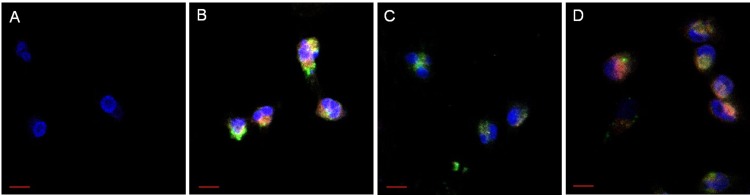
Confocal microscopy images of human breast cancer cells (MDA-MB-231) indicating uptake of fluorescent AS1411-conjugated nanoemulsions.(A) No treatment, (B) 4 hr incubation with AS1411 nanoemulsions, (C) 24 hr incubation with untargeted nanoemulsions, and (D) AS1411 nanoemulsions. (Red: Cy5-labeled AS1411, Green: FITC-labeled lipid, Blue: DAPI nuclear stain). Scale bars represent 10 μm.